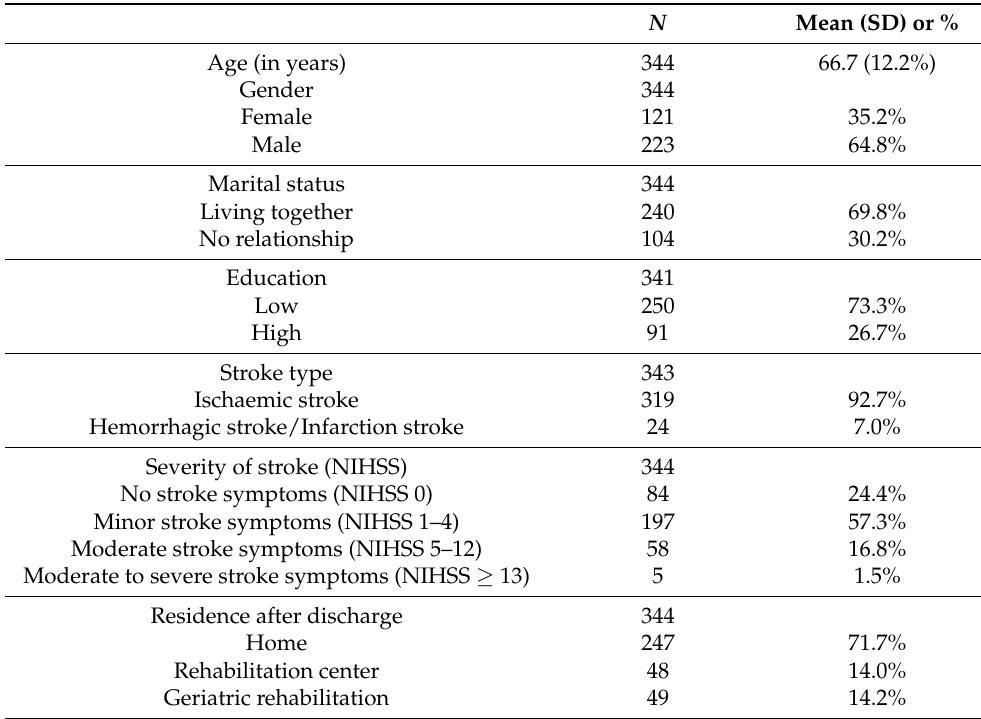
Table 1. Baseline patients’ characteristics ( n = 344).